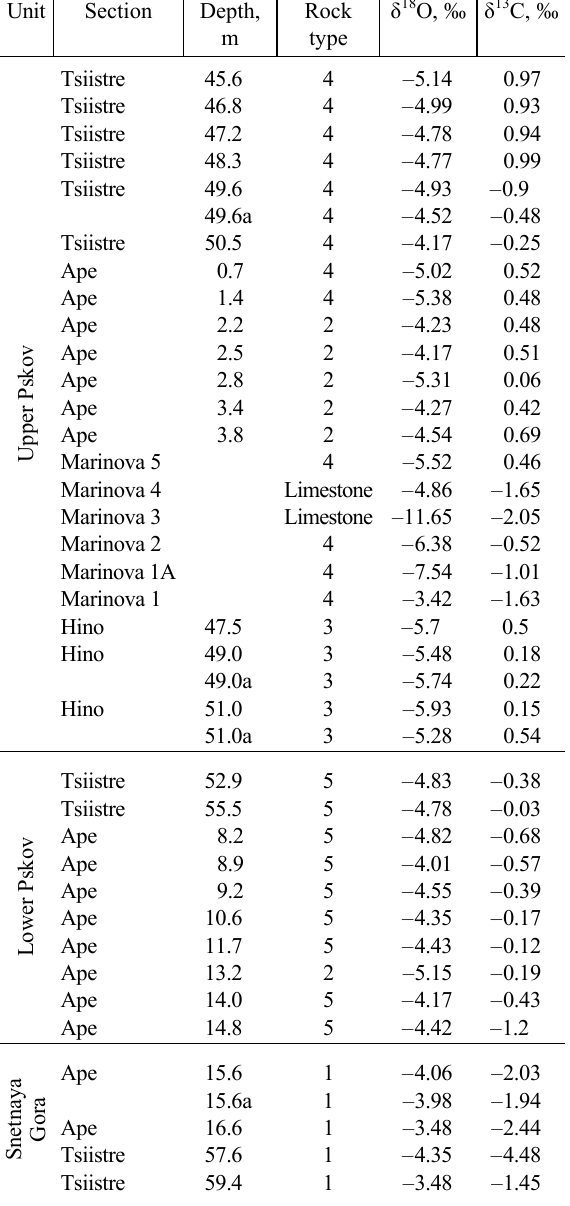
Table 3. Carbon and oxygen isotope data of the studied rocks Unit